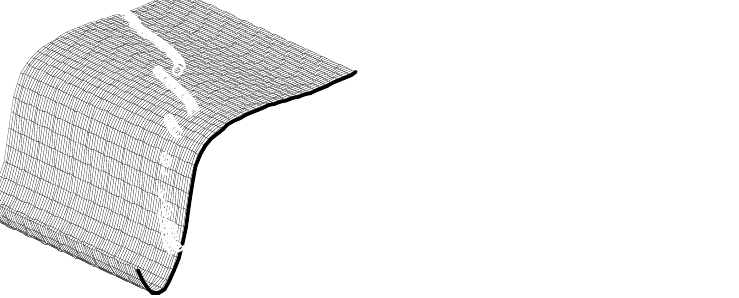
Figure 7. The position of contact points on the surface of a wheel (rail inclination 1:40).